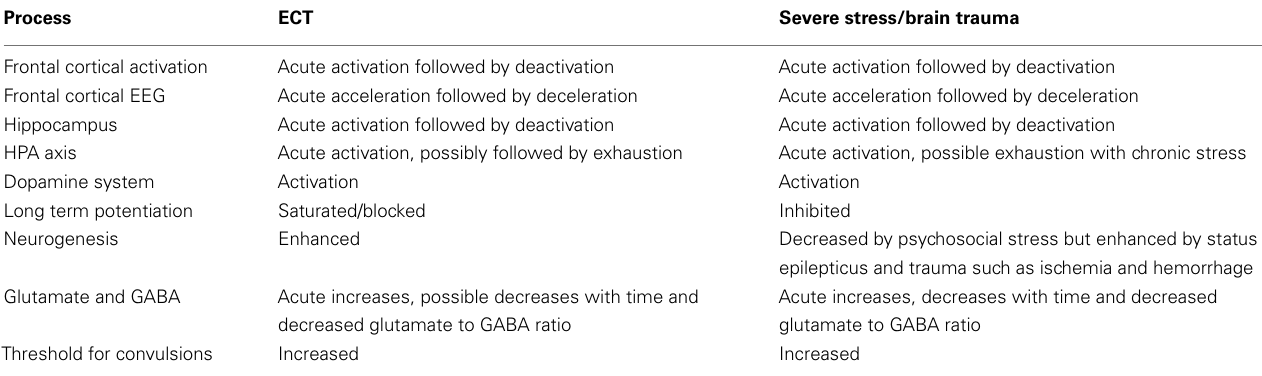
Table 1 | Suggested similarities between effects of ECT and severe stress or brain